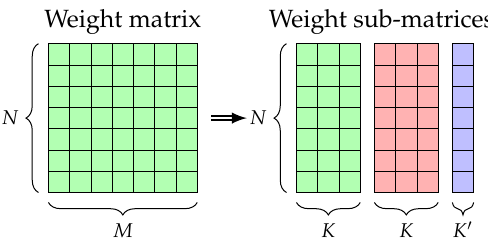
Figure 5. Splitting the weight matrix into sub-matrices with their size depending on the number of cores. N is the number of neurons in the current layer. M is the number of neurons in the next layer. K is the number of neuron processing units. K (cid:48) is the size of the last sub-matrix, with K (cid:48) ≤ K